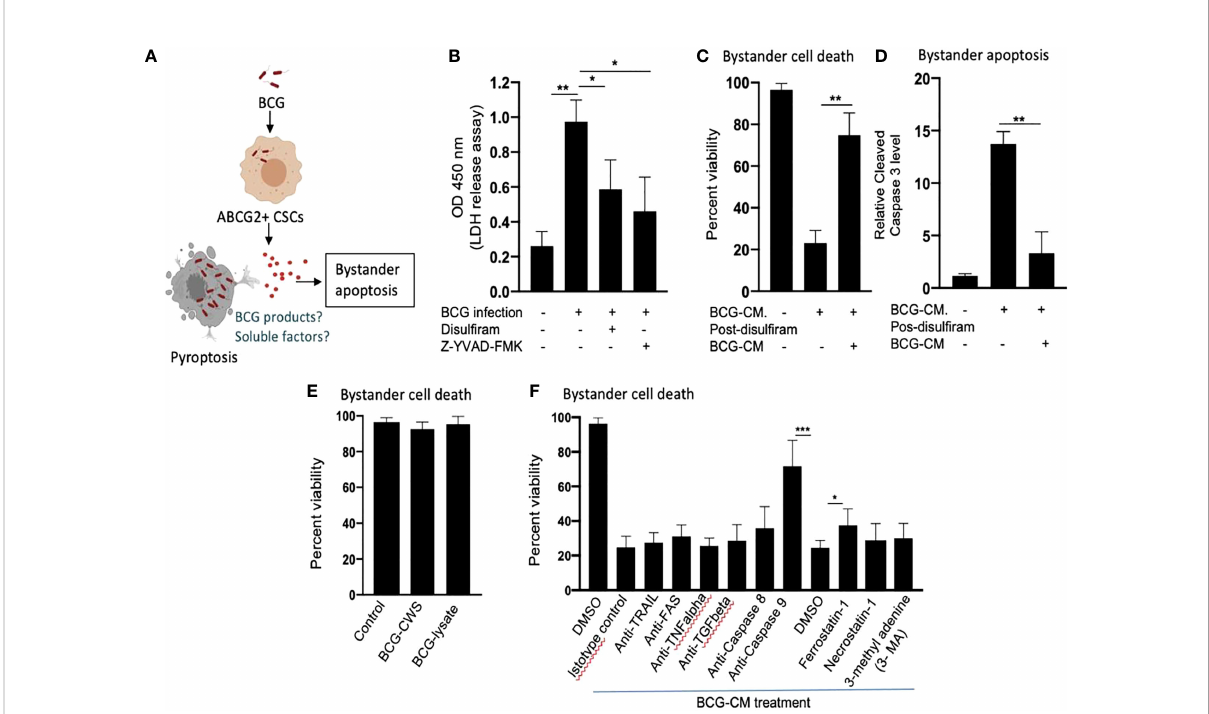
FIGURE 4 Pyroptosis-mediated secretion of soluble factors may induces bystander apoptosis. (A) The schematic is showing the experimental hypothesis. (B) The histogram is showing LDH release by BCG-infected EpCAM+/ABCG2+ CSCs on day 12. The LDH was measured after treating the BCG- infected EpCAM+/ABCG2+ CSCs with or without disul fi ram and Z-YVAD-FMK from days 8 to 12. (C, D) Data show the uninfected EpCAM +/ABCG2+ CSC viability and bystander apoptosis following treatment of BCG-CM obtained from the infected EpCAM+/ABCG2+ CSCs with or without disul fi ram treatment. (E) EpCAM+/ABCG2+ CSCs are not sensitive to BCG cell wall skeleton (BCG-CWS) and BCG-lysate treatment for a week. (F) EpCAM+/ABCG2+ CSCs were treated with various neutralizing antibodies and inhibitors during BCG-CM treatment. N = 3 independent experiments for (B – D) , and n = 4 independent experiment for (E, F) . One-Way ANOVA (B) and Student ’ s t-test (C, D, F) .*p < 0.05, **p < 0.01, and ***p < 0.001 ( B, F : one-way ANOVA with Dunnet post hoc test; C, D : Student ’ s